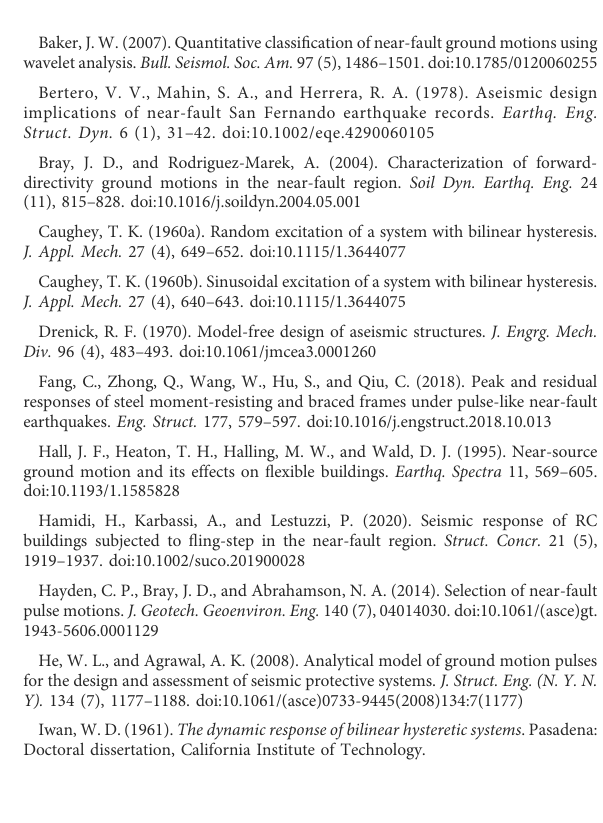
SUPPLEMENTARY DATA SHEET Closed-form expressions on the maximum interstory drifts after the fi rst impulse and the maximum interstory drifts after the second